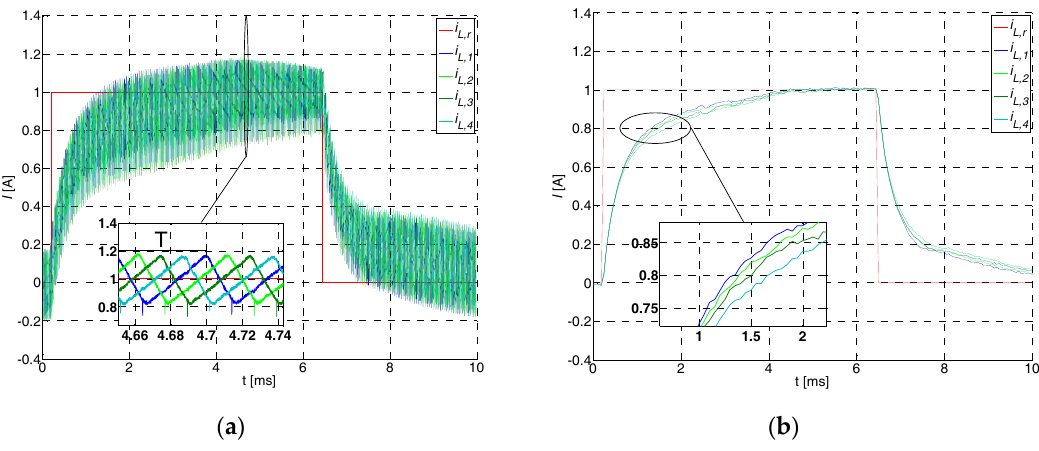
Figure 8. Phase currents’ i L ,1 ... 4 responses to step change of current reference i L , r from 0 to 1 A when integral sliding mode (ISM) is used to account model uncertainties; ( a ) real current values and ( b ) values, sampled by DSP.